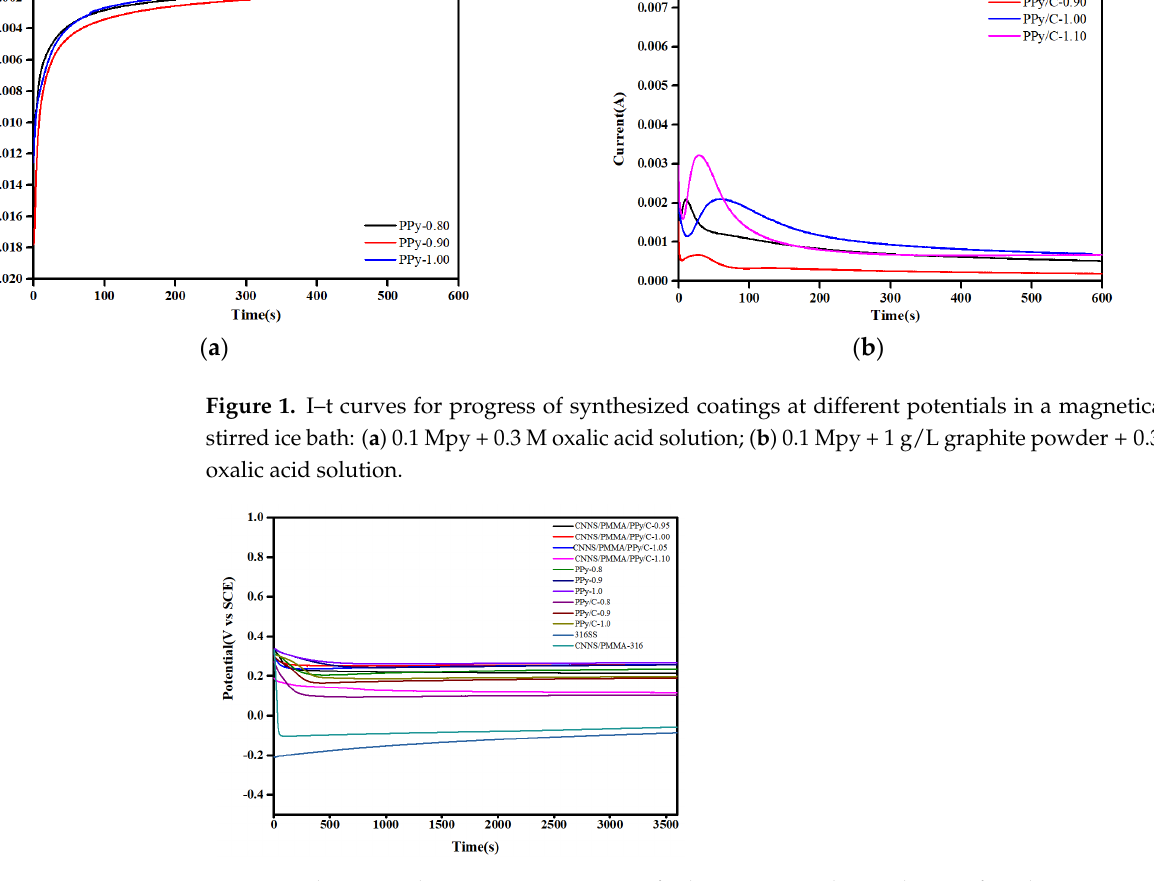
Figure 2. The E ocp values versus time curves for bare 316SS and coated 316SS for 1 h immersion.